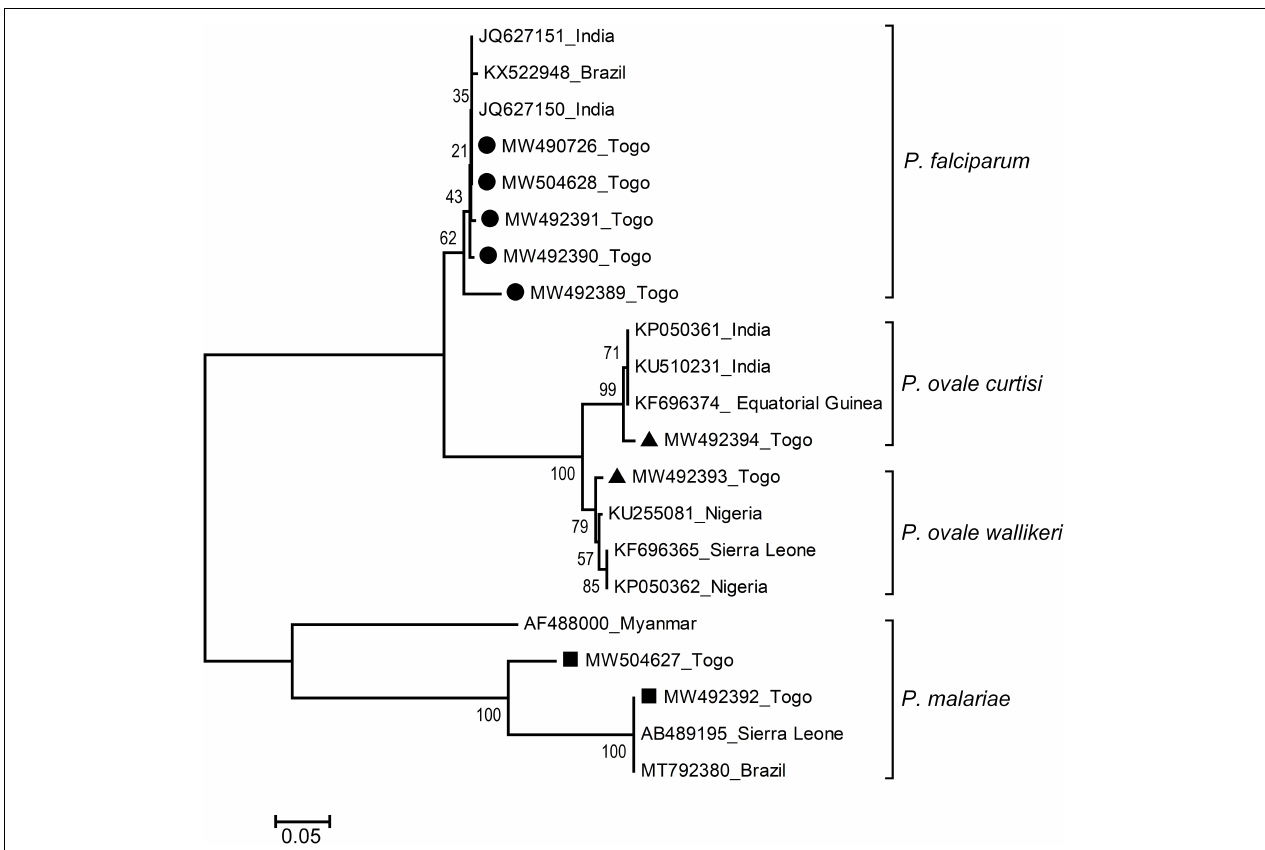
FIGURE 3 | Genetic and geographical relationships of Plasmodium species from high-transmission areas in southern Togo based on the 18S rRNA locus. The relationships were inferred by a neighbor-joining analysis of 18S SSu rRNA partial gene sequences of Plasmodium species isolates from different countries. The numbers on the branches are percent bootstrapping values from 1,000 replicates. Each sequence of Plasmodium species is identified by its accession number and geographical location (country). Gene sequences of the present study are highlighted (black circles for Pf, black triangles for Po, and black rectangles for Pm). Scale bar indicates nucleotide substitutions per